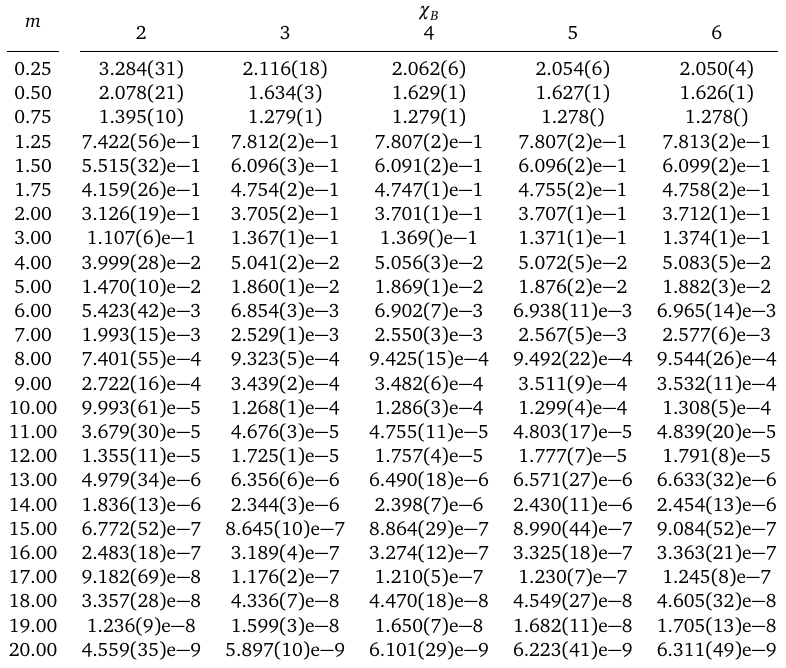
3: Numerical data for the infinite correlation length limit